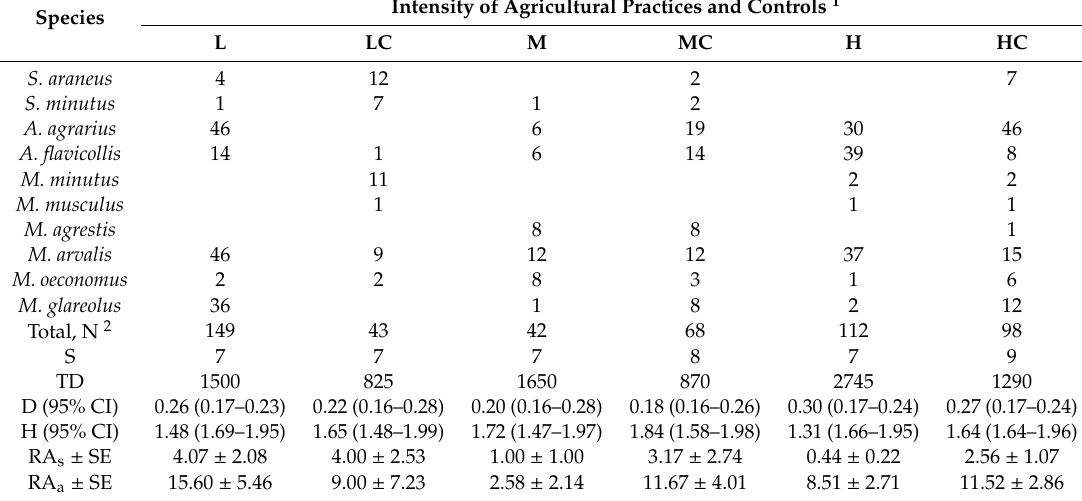
Table 4. Small mammal diversity, numbers trapped, and relative abundance (recalculated to 100 traps per day) in fruit farms according to the intensity of agricultural practices. Control data presented in Table 3. Intensity of Agricultural Practices and Controls 1 Species L